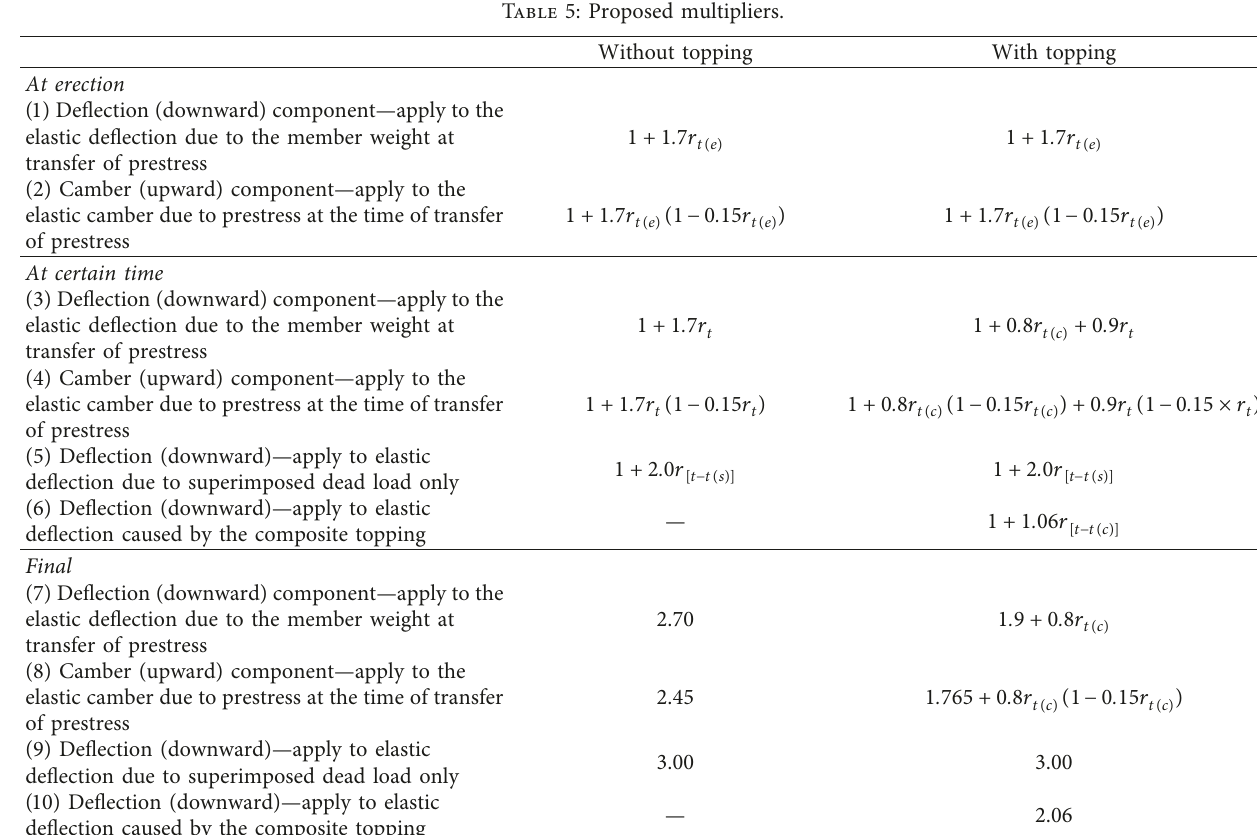
Table 5: Proposed